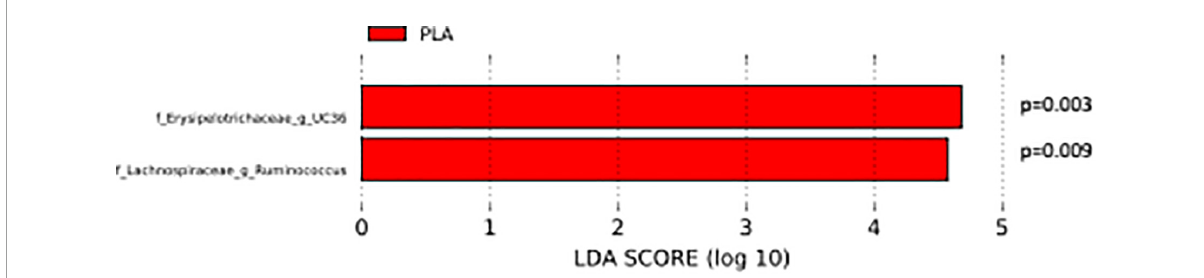
FIGURE3 Gut microbial composition and microbial markers in the FVS and PLA groups. Gut microbial markers were measured by using the LEfSe analytical tool with a cutoff value of LDA > 2.0) in both the FVS and PLA groups. “g_UC” and “f_UC” represent unclassified bacteria at the genus level and family level,